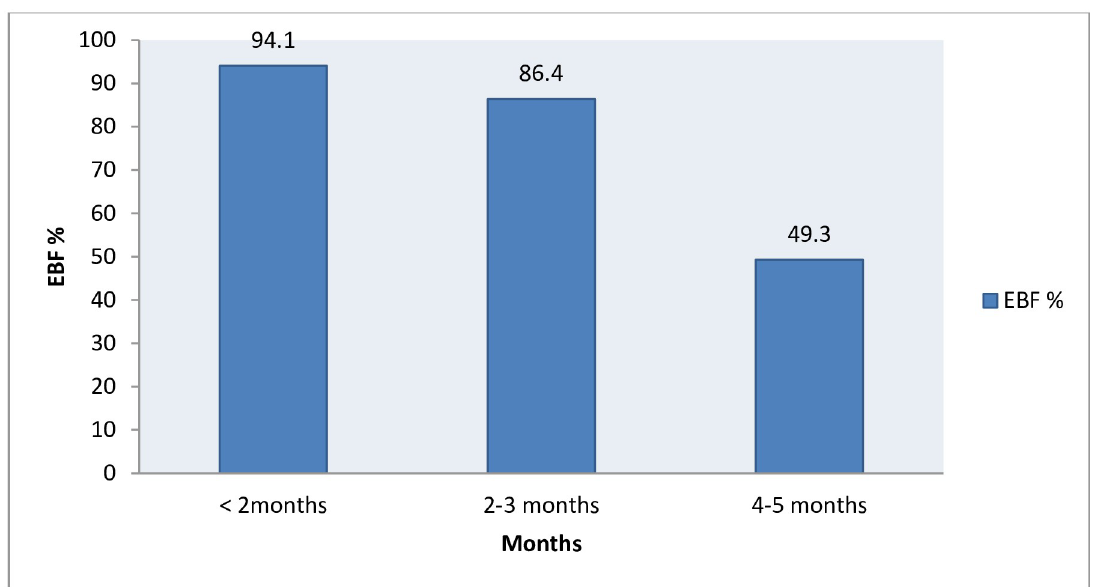
Fig 1. A month-specific lifetime exclusive breastfeeding among